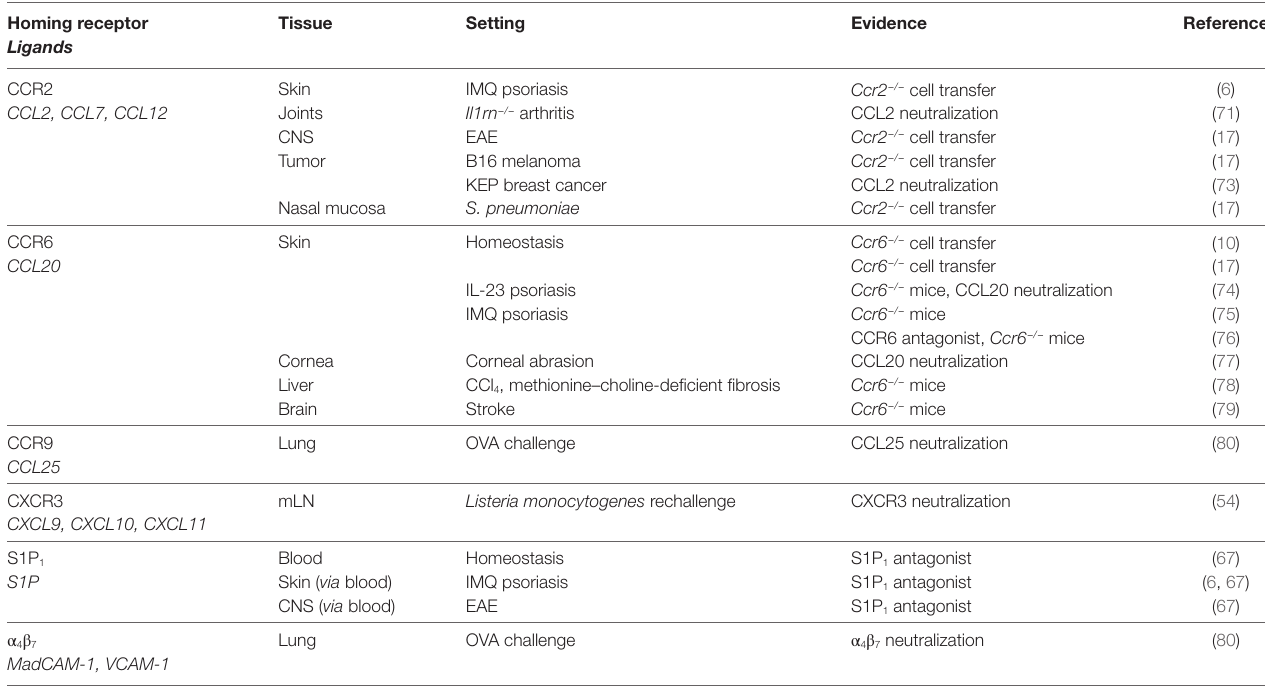
TABLe 1 | Homing receptors involved in murine γδ T17 cell migration. Homing receptor